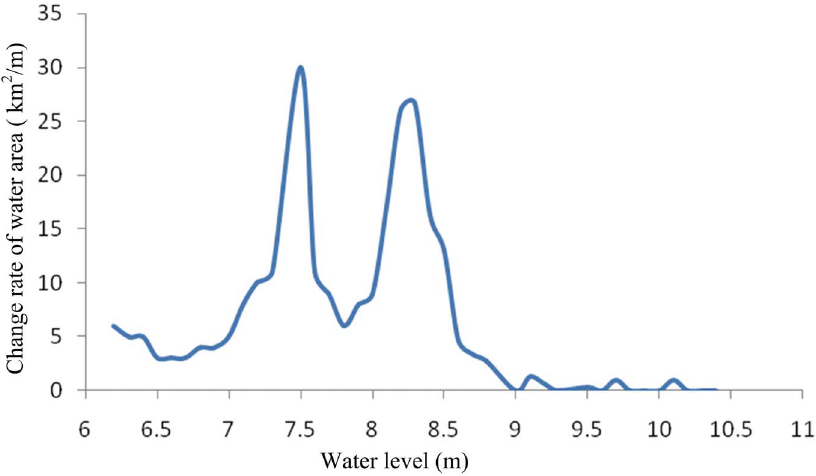
Figure 5. Relationship between the rate of change in water area and the water level [ 47 ] . Change rate of water level is the change of water area (km 2 ) when the water level increases by 1 m. The key water levels of the Baiyangdian wetland are 7.5 and 8.3